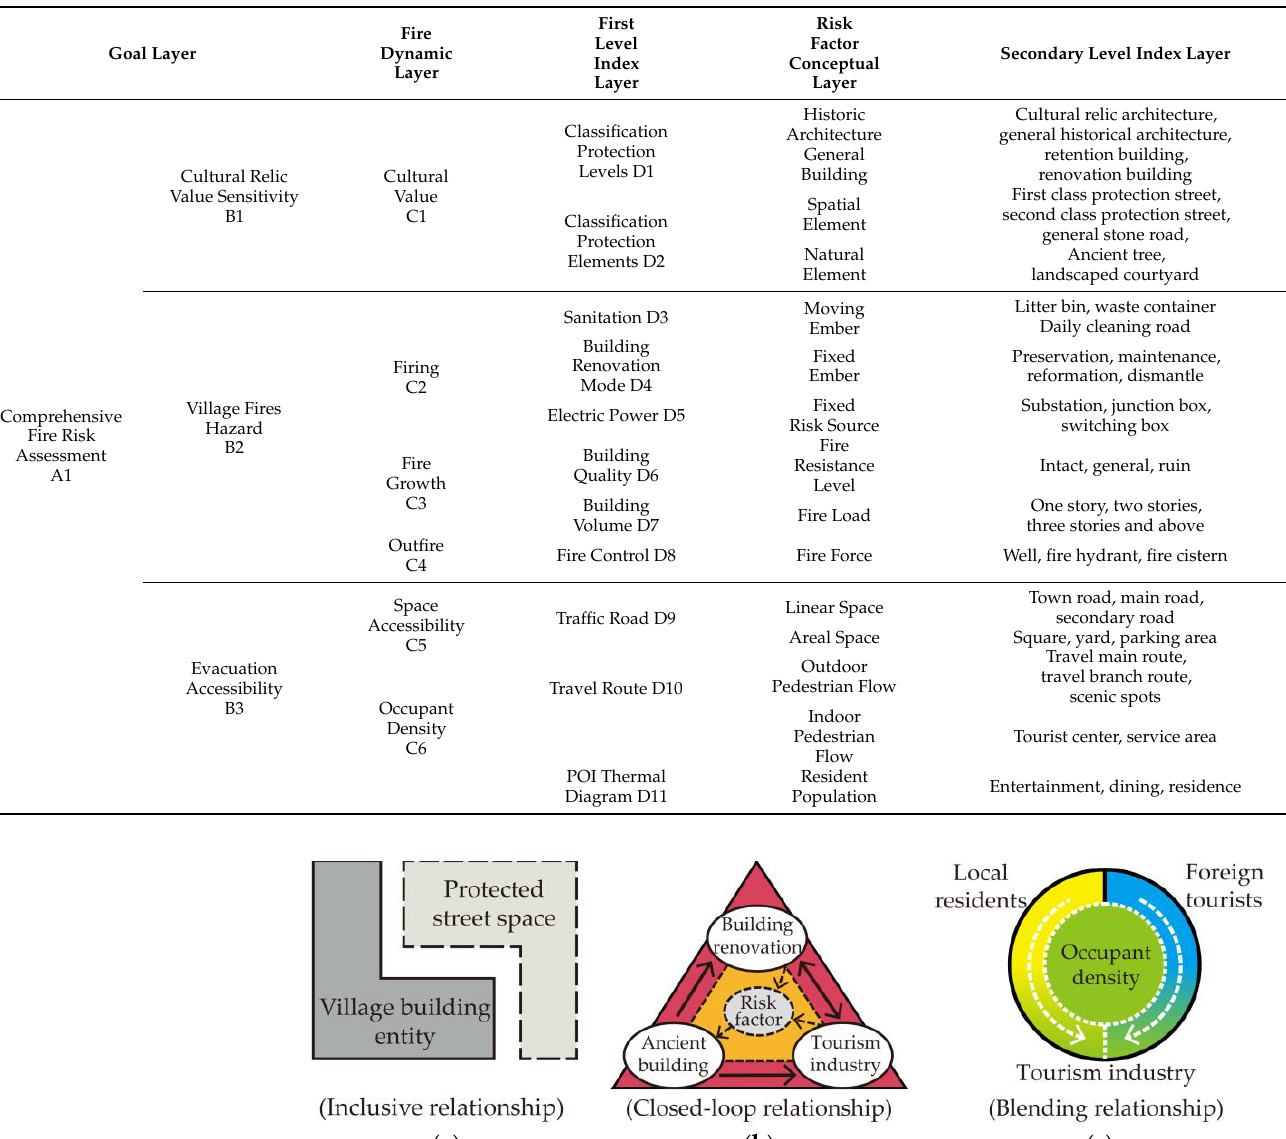
Table 2. Fire risk assessment index.